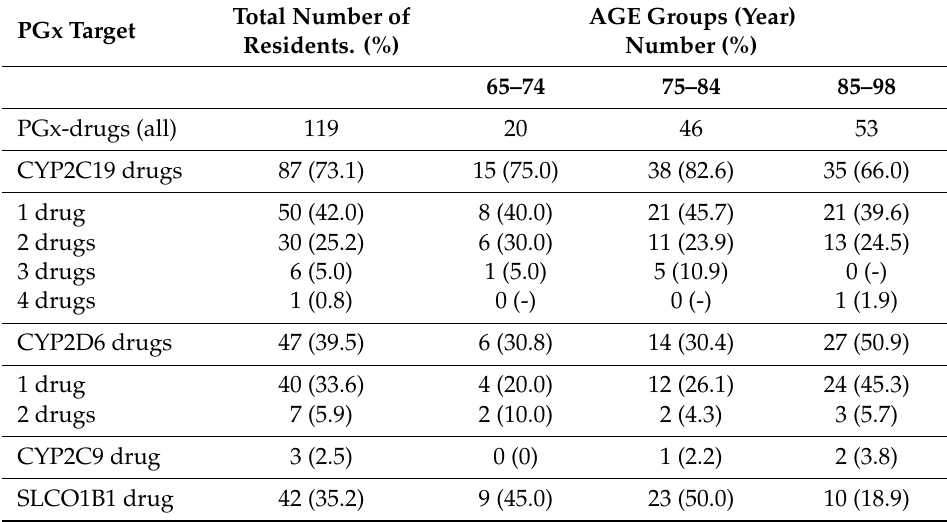
Table 2. Number of residents using drugs with PGx actionable